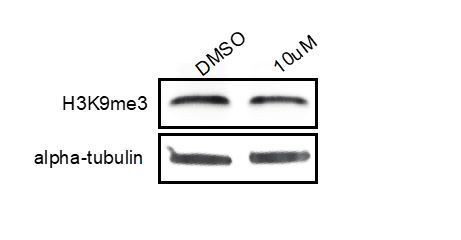
Western Blot on HOAP[mel] ovaries treated with DMSO or methotrexate probed with anti-H3K9me3.We detected minimal change in H3K9me3 abundance across the two treatments in HOAP[mel] (the HOAP[yak] genotype died at the pupal stage). In fact, the 10uM treated-flies may have slightly less H3K9me3. (1:1000 for both antibodies).